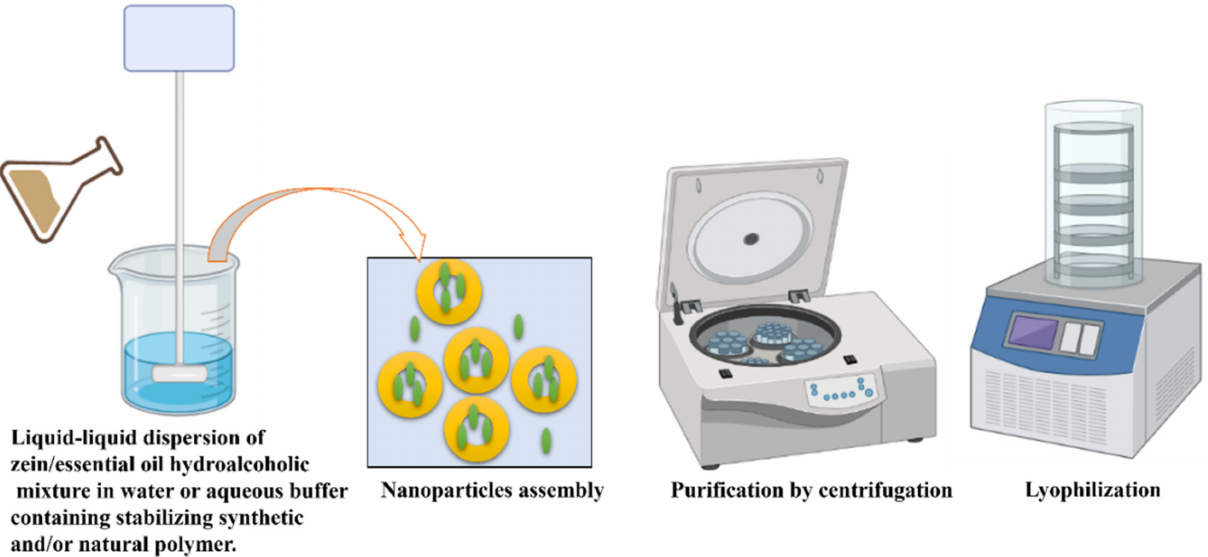
Figure 6. The encapsulation of essential oils into zein by the liquid–liquid dispersion approach and the separation and lyophilization of the formulated